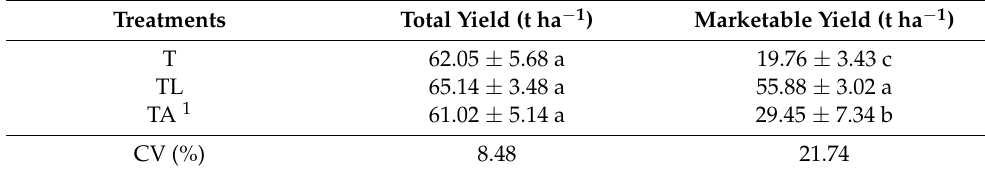
Table 2. Potato tuber yield as a function of Trichoderma spp.